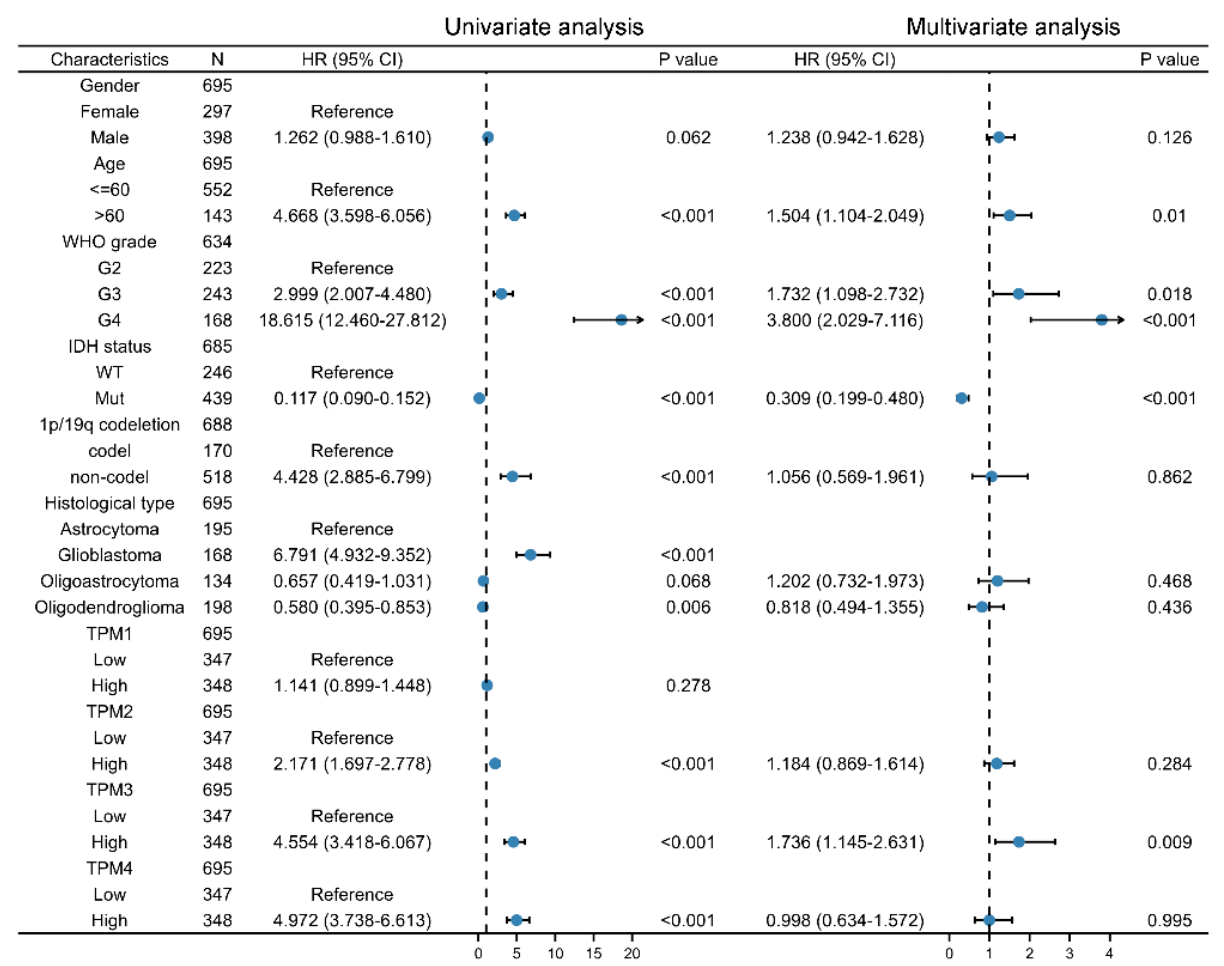
Figure 5. Univariate and multivariate Cox regression analysis risk score of TPM expressions and related key clinical characteristics. HR > 1 indicates disadvantageous factors, and HR < 1 indicates protective factors.